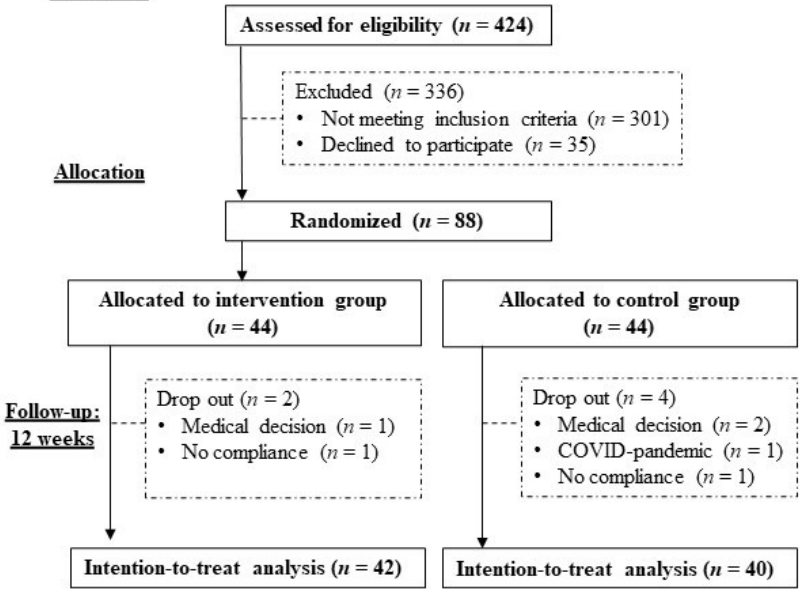
Figure 1. Study flow chart. Table 1. Baseline characteristics of enrolled participants.